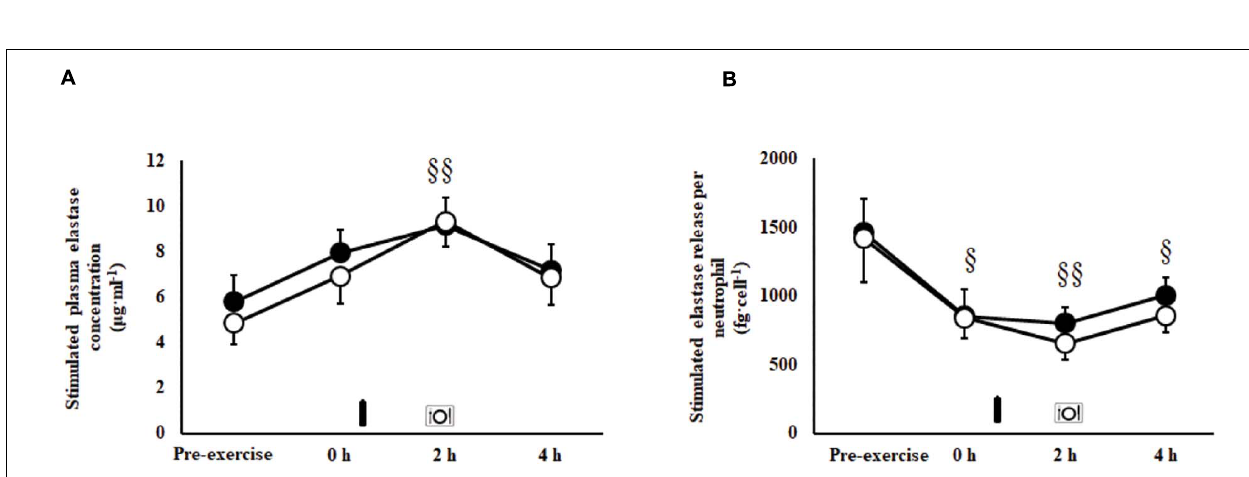
FIGURE 3 | Blood glucose (A) and serum insulin (B) concentrations after 2 h HIIT exercise protocol in temperate ambient conditions and consumption of a chocolate dairy milk (CM: (cid:4) ) or the carbohydrate-electrolyte (CEB: ◦ ) recovery beverage. Mean ± SEM ( n = 17): aa P < 0.01 vs. CM.